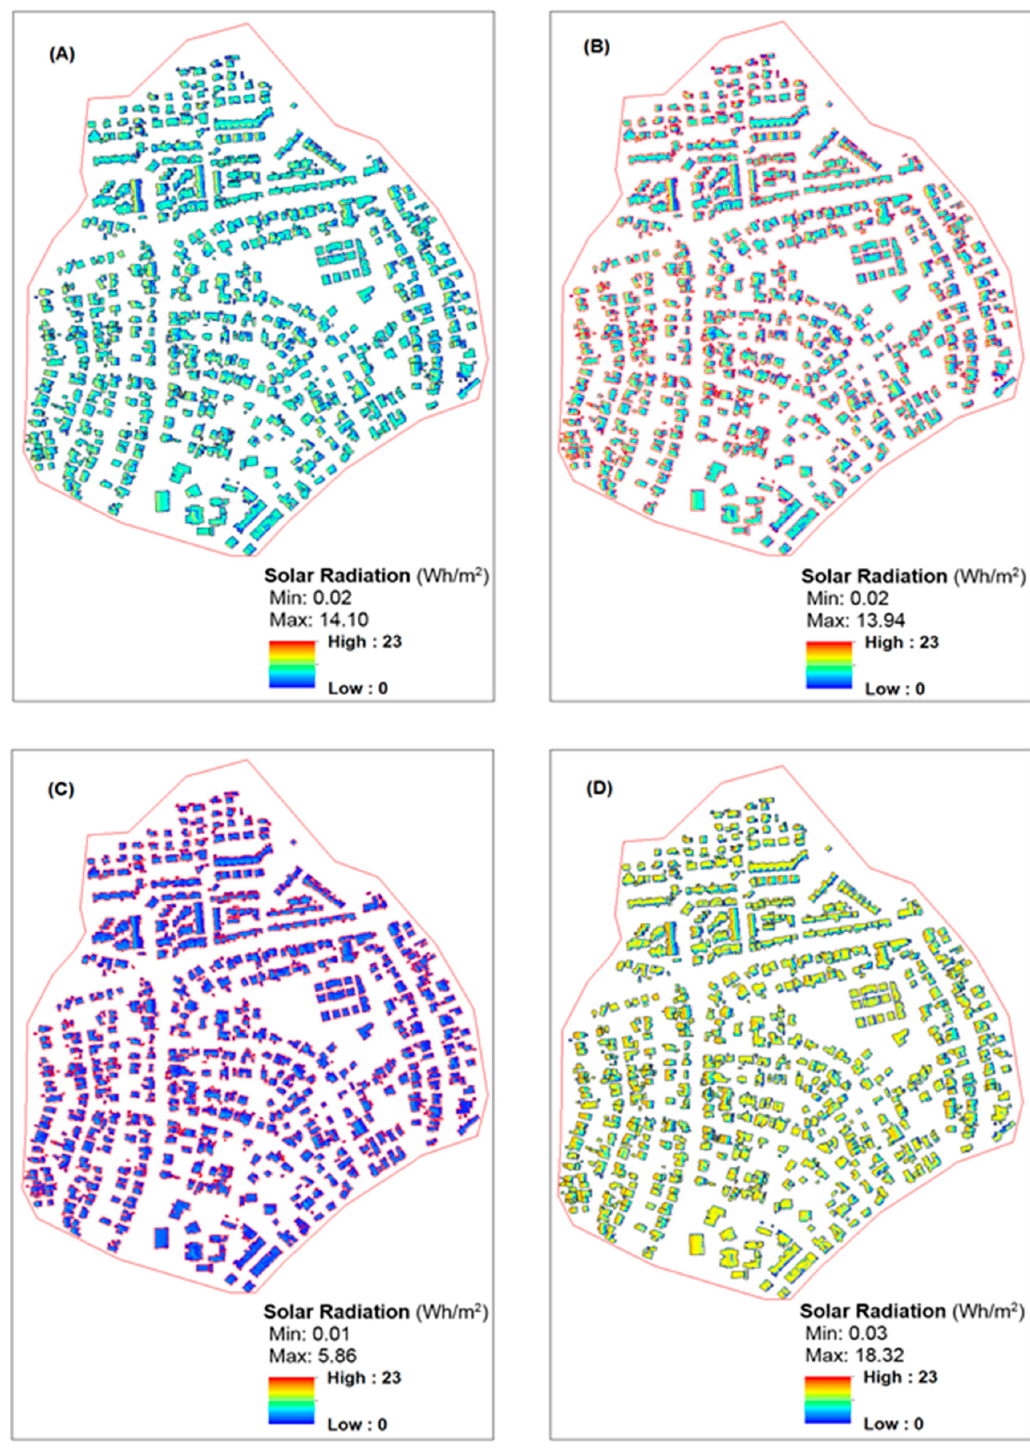
Figure 12. Incoming solar radiation (Wh/m 2 ) at 15:00: ( A ) Vernal equinox (21 March), ( B ) autumnal equinox (23 September), ( C ) winter solstice (22 December), and ( D ) summer solstice (21 June).